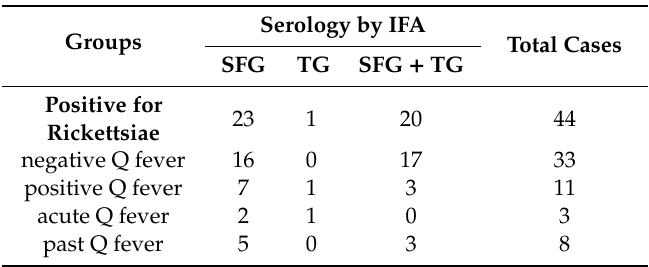
Table 3. Serological evidence of rickettsial infection in the outbreak investigation. IFA = reference method, positive cuto ff of ≥ 1 / 512. Rickettsiae indicated by the spotted fever group (SFG) and typhus Group